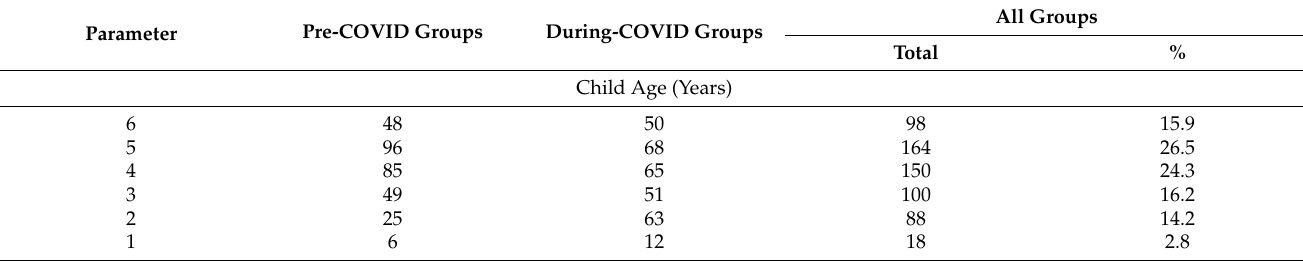
Table 1. Demographical characteristics of the adults who responded to the